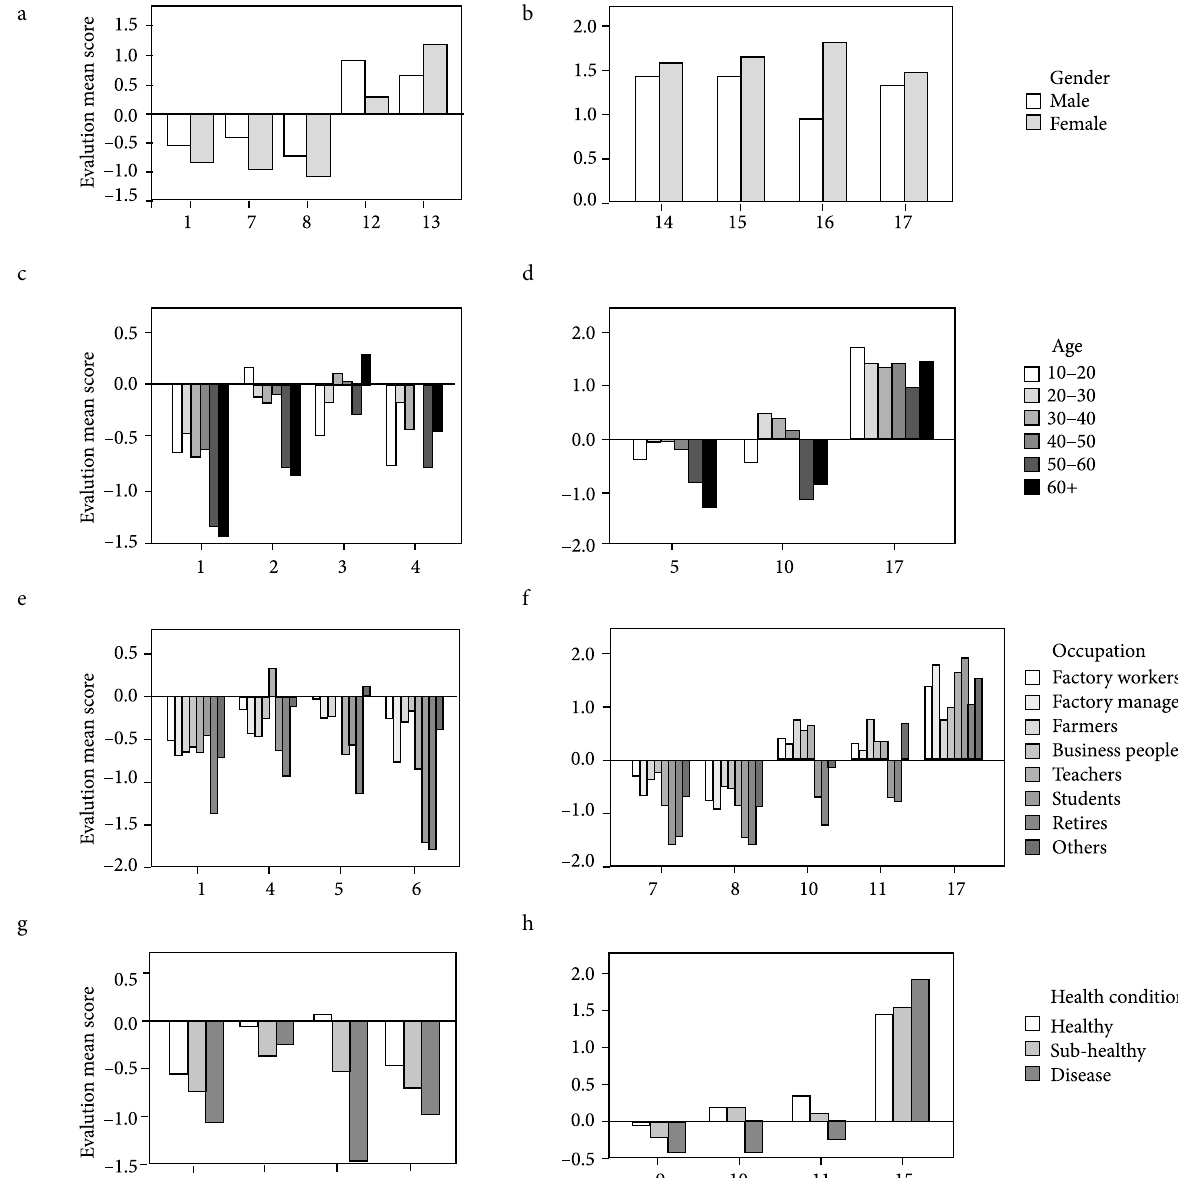
Fig. 8. Mean evaluation scores with different demographical factors, with the digital codes shown in Table 2 and Table